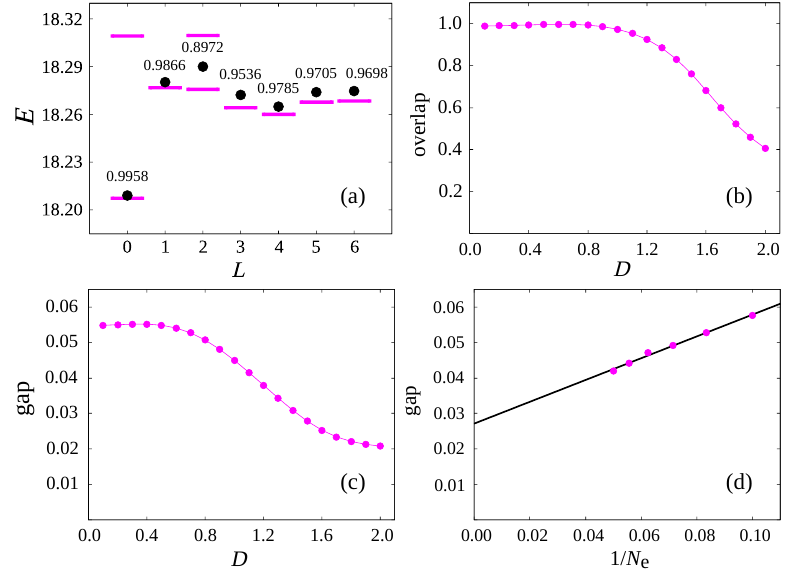
Figure 3: Numerical results about the Ψ 221 state. The system parameters are − 1,1 = 6, N b = 6, N t = 11, N b = 21 in panels (a-c). (a) The energy spectrum at N t φ φ e e D = 0.7. The exact eigenstates are represented by lines, the trial states are rep- resented by dots, and their overlaps are displayed as numbers. (b) The overlaps between the exact ground state and the trial state at different D . (c) The neutral gaps at different D . (d) Finite size scaling of the neutral gap versus the total number = N t + N b of electrons N at D = 0.7. e e e